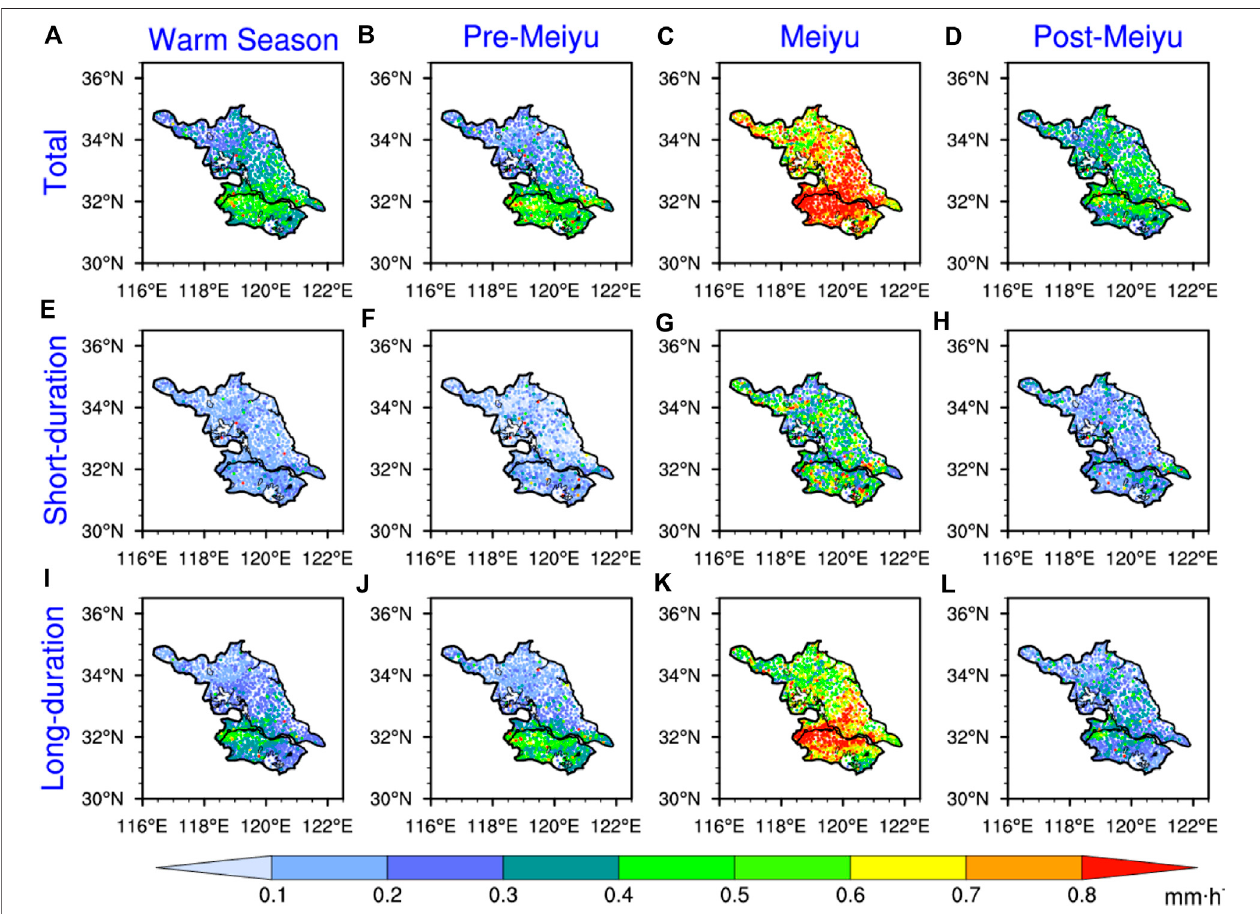
FIGURE 8 | Spatial distributions of the diurnal peak of PA (PPA) for total rainfall (A-D) , short-duration rainfall (E-H) and long-duration rainfall (G-I) in warm season and each sub-season of warm season (four rows separately represent Warm season, Pre-Meiyu, Meiyu and Post-Meiyu period) averaged over 2013 – 2017.